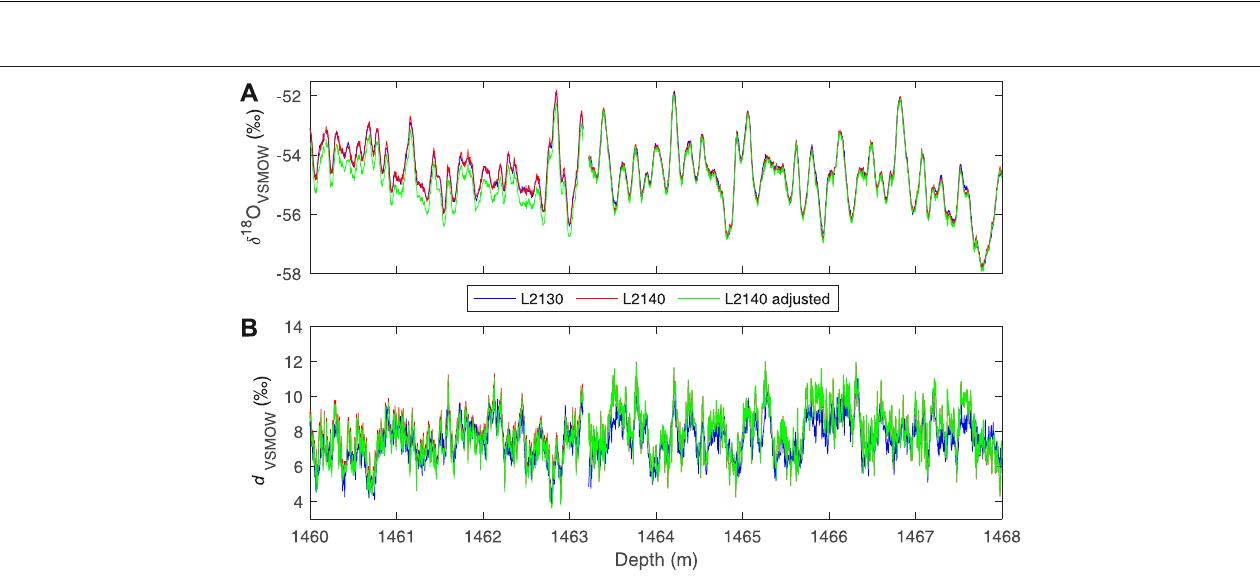
FIGURE 7 | Comparison of (A) δ 18 O and (B) deuterium excess for the South Pole ice core (SPC14) for a short section of the core at high (0.5 cm) resolution, from two different instruments. The data from the Picarro L2130- i (blue) are calibrated with simple two-point calibration ( Eq. 7 ). Data from the Picarro L2140- i are shown with both the simple (red) and adjusted calibration ( Eq. 10